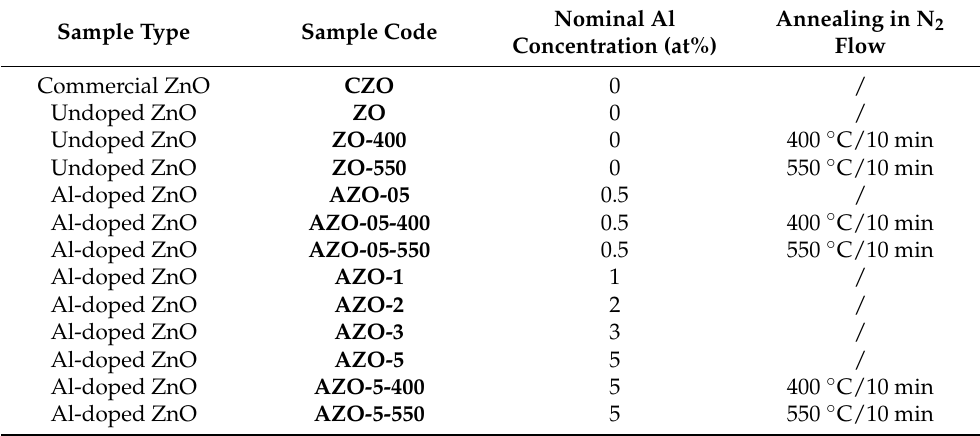
Table 1. Undoped, Al-doped and commercial ZnO sample codes.